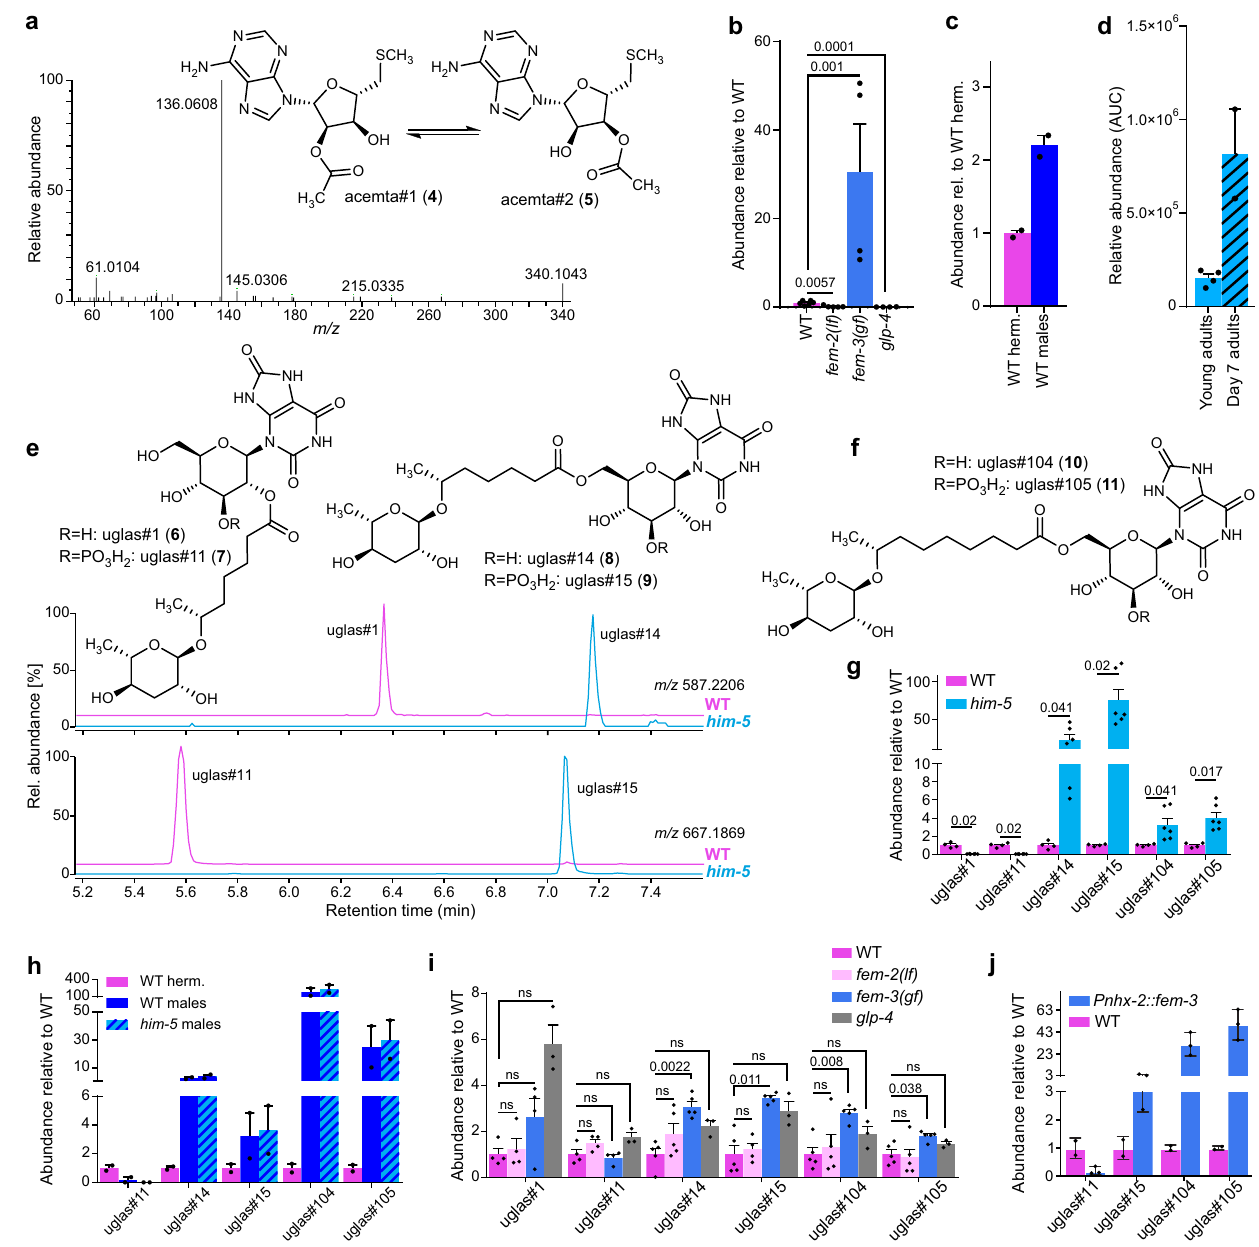
Fig. 2 | Nucleoside-derived metabolites are enriched in males. a MS2 fragmen- tation of acemta#2 ( 5 ) in positive (ESI+) ionization mode. b Abundance of acemta#2 in endo -metabolome extracts of fem-2(lf) , fem-3(gf) , and glp-4 mutants relative to WT. Data represent four or six biologically independent experiments, and error bars represent mean±s.e.m. P values were calculated using the log 10 - transformedrawdataandtwo-sidedWelch t tests. c Comparisonofacemta#2levels inhand-pickedWTmalesandhand-pickedWThermaphrodites.Datarepresenttwo biologically independent experiments, and error bars represent mean±s.e.m. d Comparisonofacemta#2levelsinyoungadultsandold(day7) him-5 adults.Data represent two (day-7 adults) and four (young adults) biologically independent experiments, and error bars represent mean±s.e.m. e Structures and sex- speci fi city of uric acid glucoside derivatives incorporating the 7-carbon sidechain